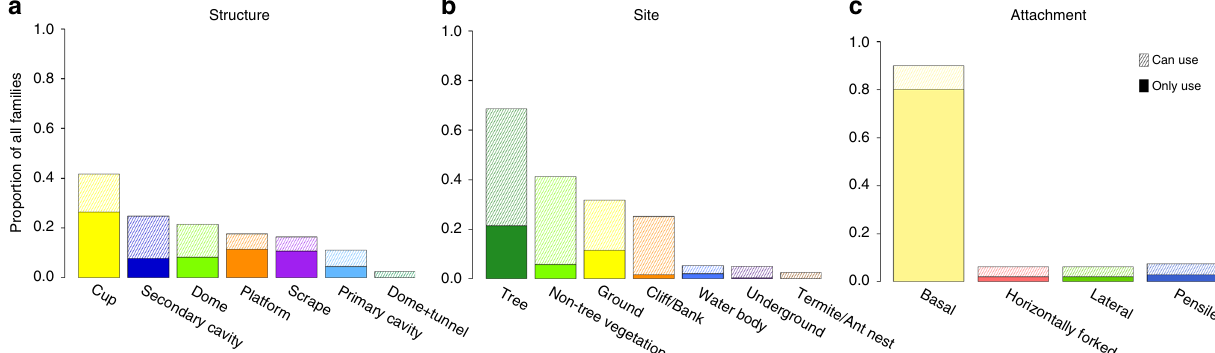
Fig. 1 Frequency of nest character states distributed across avian families. Proportion of avian families using the character states of a nest structure, b nest site, and c nest attachment. A fi lled bar indicates the proportion of avian families whose nests only have the focal character state, whereas a striped bar indicates the proportion of avian families whose nests have mixed states including the focal